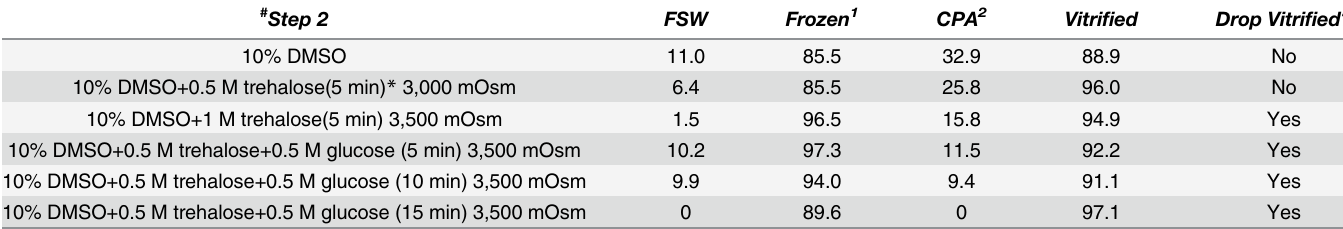
Table 2. Symbiodinium change in quantum yield (%) after exposure to vitrification treatments and 24 h maintenance in